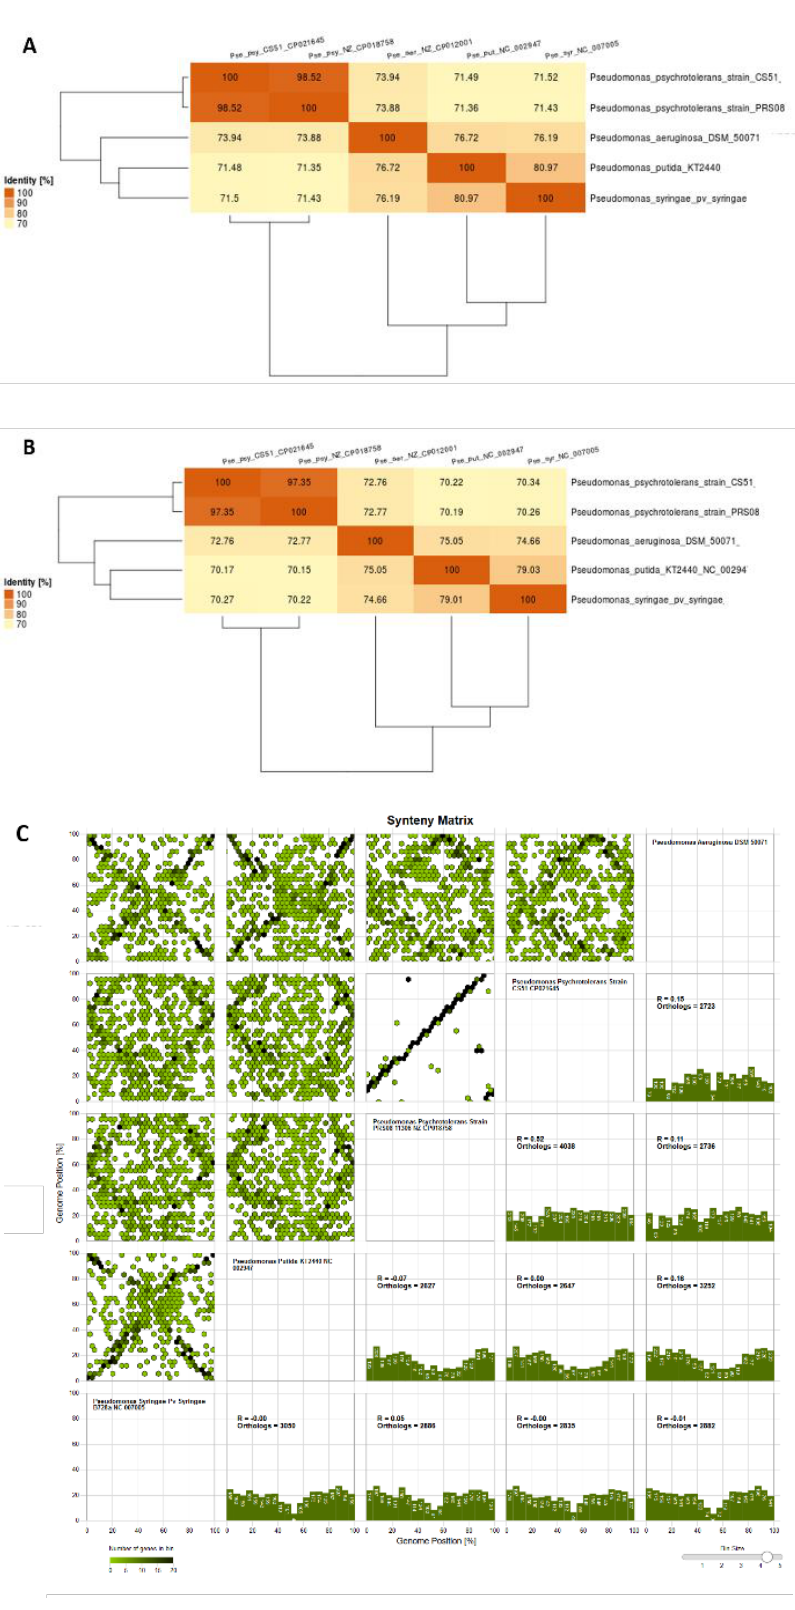
Figure 5. ( A ) Average nucleotide identity (ANI), ( B ) average amino acid identity (AAI) values of P. psychrotolerans CS51 and four Pseudomonas species, and ( C ) synteny matrix of P. psychrotolerans CS51 with related species.